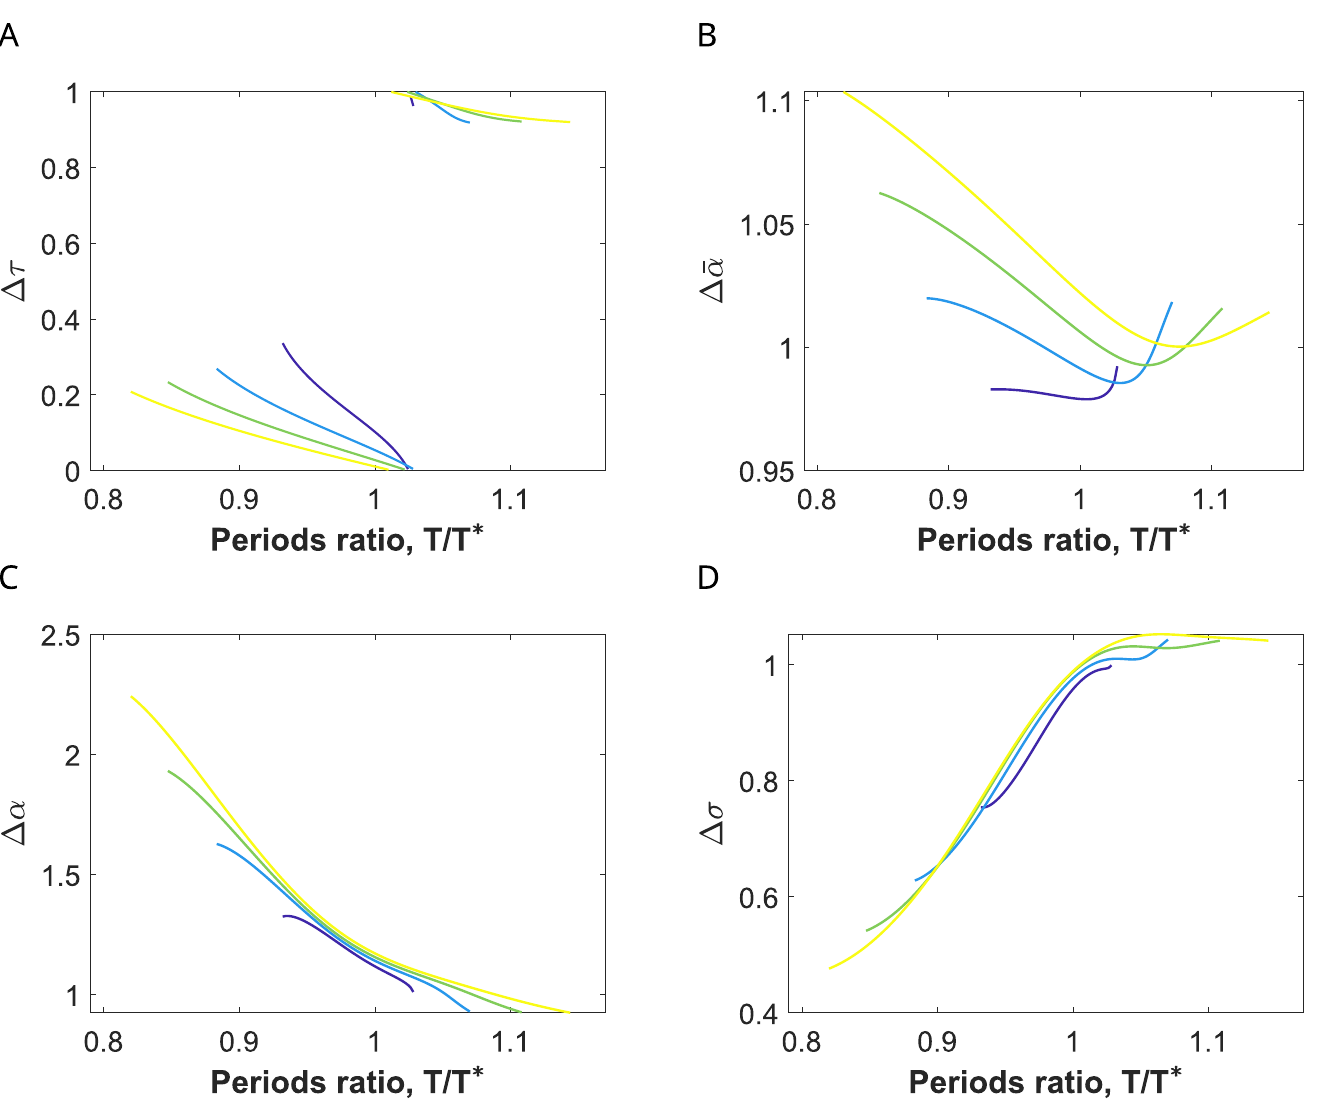
Fig 10. Input effects on the E-cell evoked response for entrained network close to a Hopf bifurcation. Factors (A) Δ τ , (B) D � a , (C) Δ α and (D) Δ σ describing changes in the E-cell response within the 1:1 phase-locking region for orbits calculated along the amplitudes A = 0.025 (dark blue curves), A = 0.05 (blue curves), A = 0.075 (green curves) and A = 0.1 (yellow curves). Factors are computed for periodic solutions of the system (1)-(2) perturbed by a von Mises type of input with κ = 2. Notice that the periodic solutions are found for smaller intervals than those predicted by the rotation number using the phase reduction (see Fig 9C).